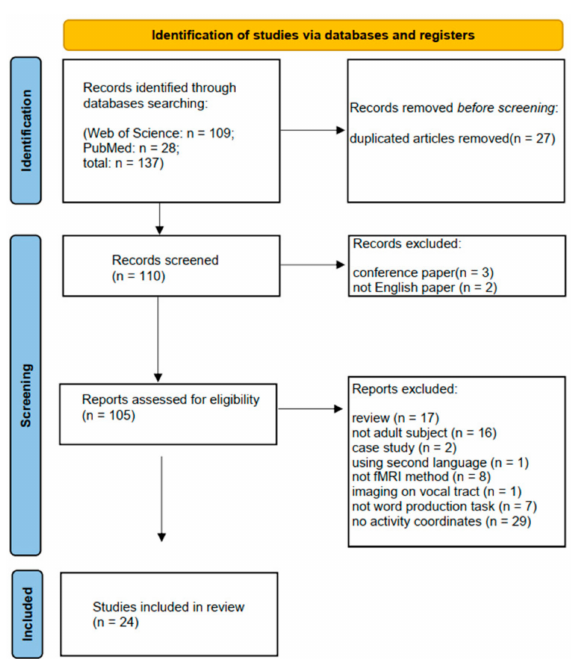
Figure 1. Flow diagram for identification and selection of